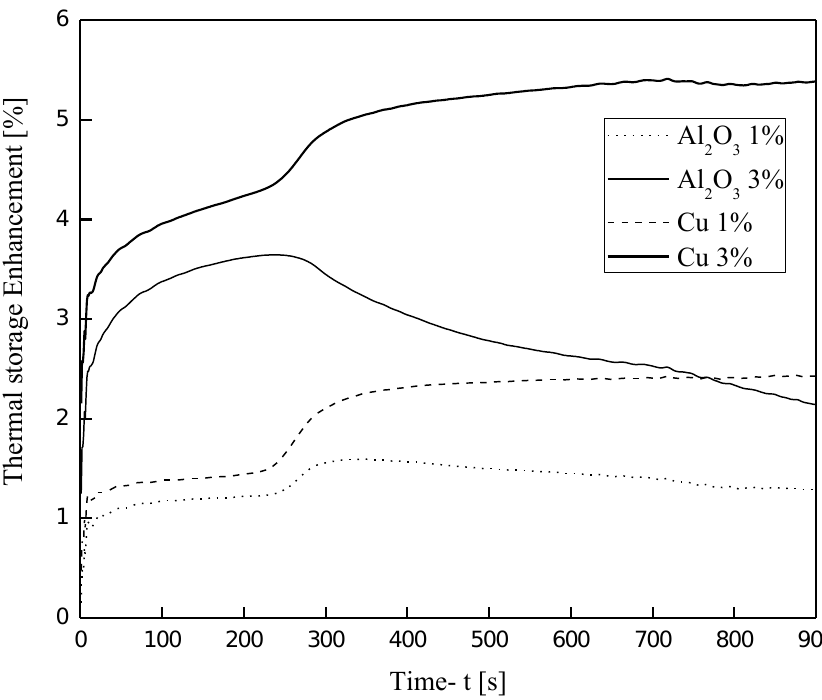
Figure 17. Thermal energy storage enhancement with the nanoparticles’ utilization.